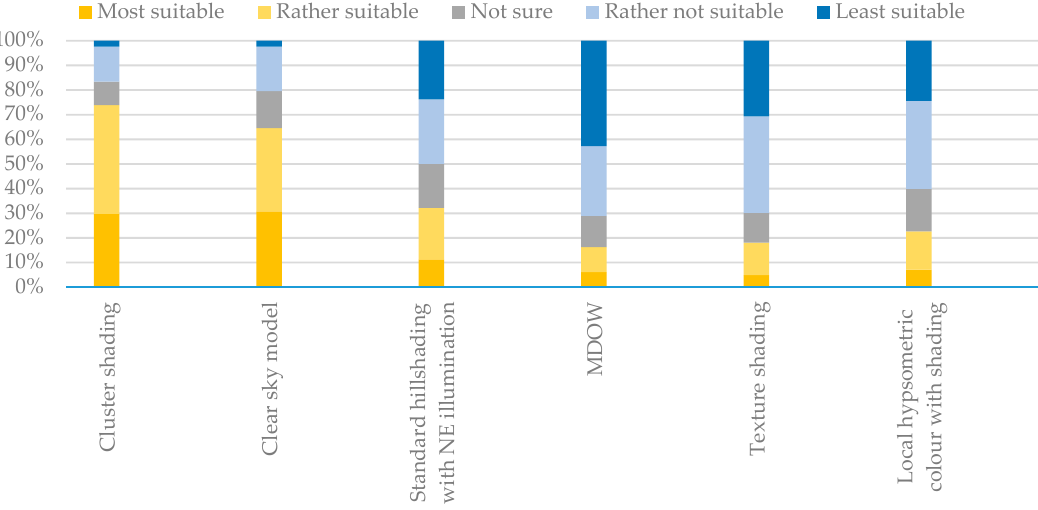
Figure 10. Survey results for drumlins.